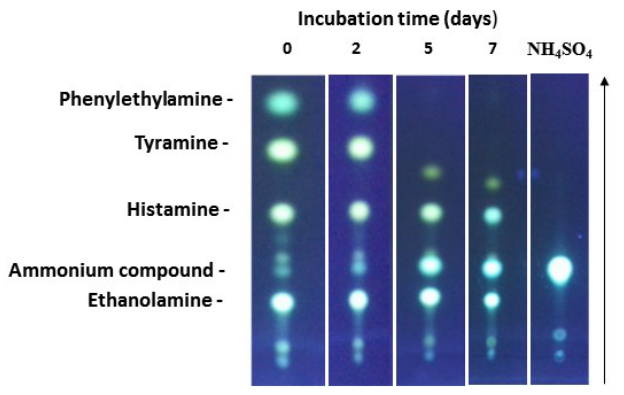
Figure 4. Kinetics of BA degradation by D. hansenii H525 as detected by TLC. Cells were incubated at 30 °C in phosphate buffer with 0.25 mM of each amine. One sample contained only 0.25 mM ammonium sulfate and remained non-inoculated. The arrow indicates direction of